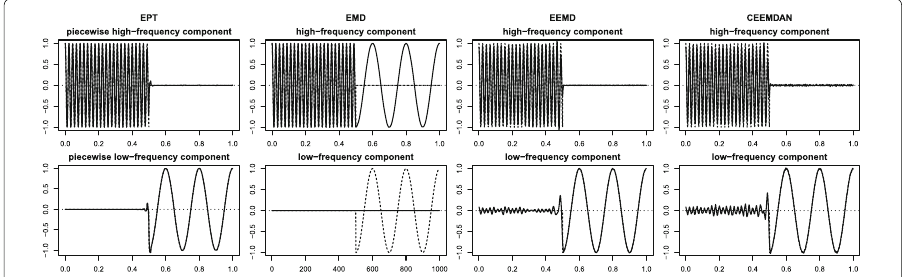
Fig. 14 Decompositions of test signal X t = cos ( 90 π t ) I ( t ≤ 0.5 ) + cos ( 10 π t ) I ( t > 0.5 ) by the proposed method, EMD, EEMD, and